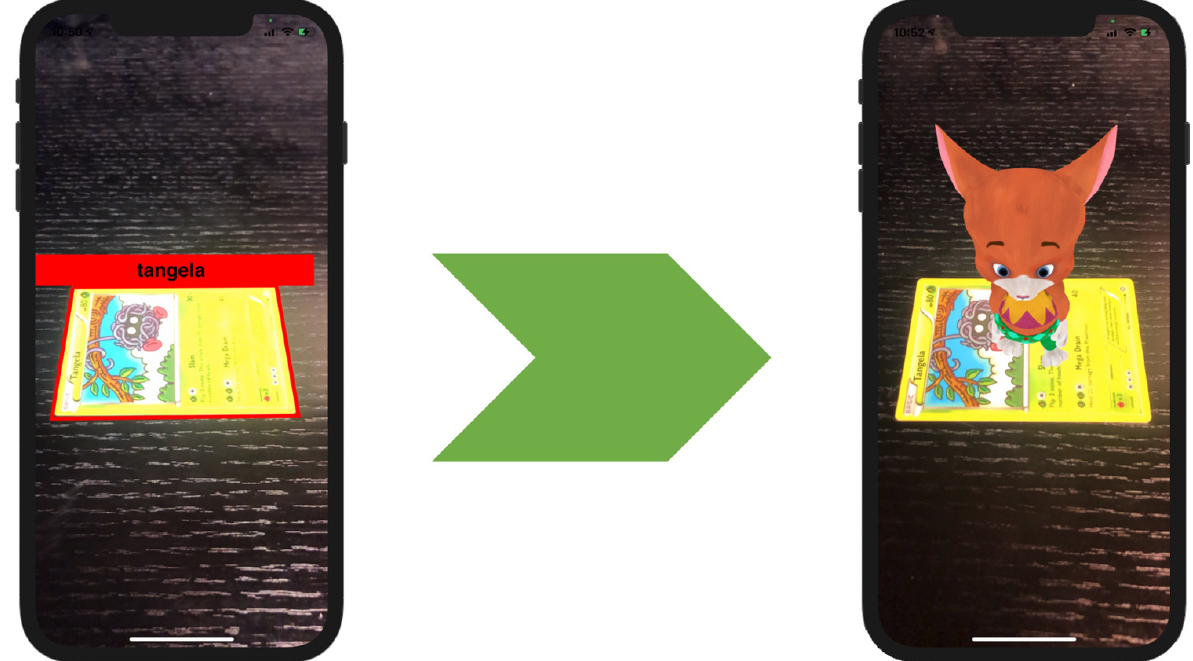
Figure 7. Machine learning and augmented reality incorporation module where the object detection algorithm using the deep neural network ( left ) can easily find the marker in the scene and produce the augmented reality experience ( right